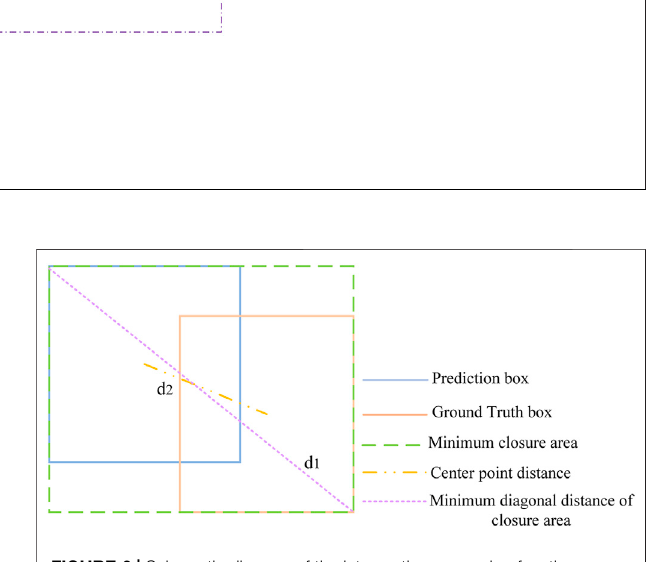
FIGURE 6 | Schematic diagram of the intersection over union function